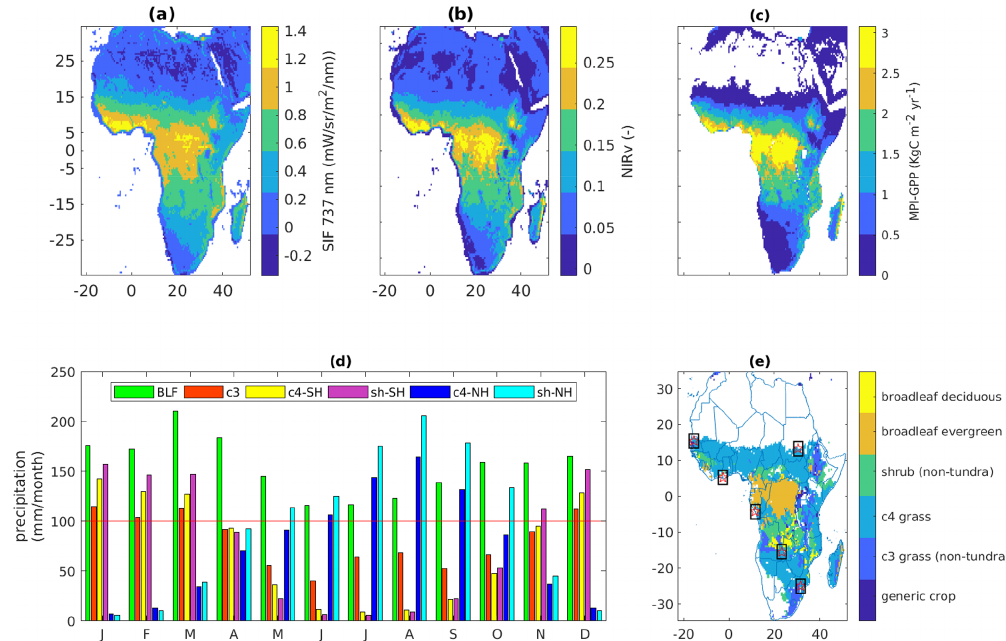
Figure 1. Annual mean SIF (a) and NIRv (b) averaged over the years 2007–2016 at 0 . 5 ◦ × 0 . 5 ◦ resolution. (c) Climatology of gross primary production (Beer et al., 2010) at 0 . 5 ◦ × 0 . 5 ◦ resolution. (d) Monthly average precipitation computed from the GPCC product covering the period from 1951 to 2000 for the major biomes of Africa. The red line indicates a reference of 100mm per month. (e) Vegetation types from the terrestrial biosphere model SiBCASA. The white color refers to non-vegetated regions. The rectangular window with a five-pointed star at the center shows the distribution of flux towers in